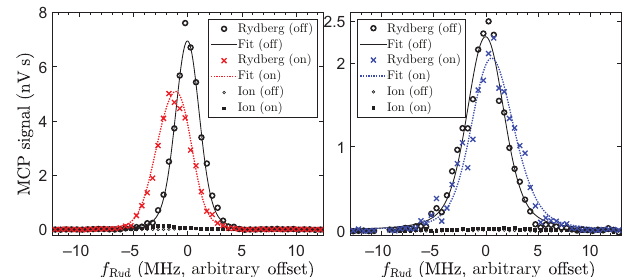
FIG. 6. The evidence for an ICE shift at the AIZs obtained for n g = 72: “on” and “off” denote the application of the ICE beam. The measurements are binned over a frequency range of 250 kHz, each data point corresponding to the average over 100–200 measurements. The fits (lines) display the simula- tions that model both signals simultaneously (Appendix C 1). Left: the first red-detuned AIZ ( (cid:4)ν ICE = − 1) recorded with / I (cid:7) P ICE = 34 mW. The best fit to the data yields ((cid:4) f ) ICE ( − 1.62 ± 0.04 ) × 10 − 6 MHz /( W m − 2 ), while the predicted shift is − 1.46 × 10 − 6 MHz /( W m − 2 ). Right: the first blue-detuned AIZ ( (cid:4)ν ICE = + 1) recorded with P ICE = 29 mW, resulting in the / I (cid:7) ( + 2.1 ± 0.25 ) × 10 − 6 MHz /( W m − 2 ) fitted value ((cid:4) f ) ICE [predicted + 1.50 × 10 − 6 MHz /( W m − 2